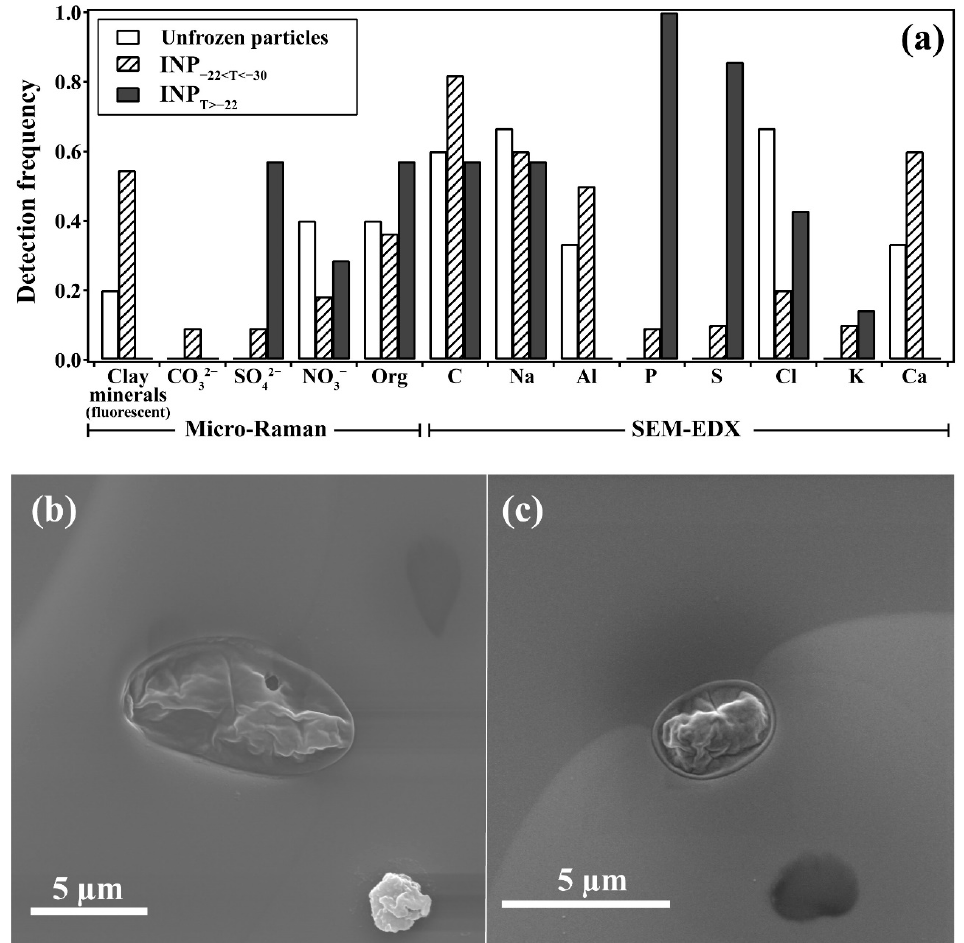
Figure 2. Summary of chemical and morphological characterization by micro-Raman analysis and scanning electron microscopy–energy-dispersive X-ray spectroscopy (SEM-EDX). The shading indicates INPs that formed ice crystals in individual particle chemical analysis: ( a ) above − 22 °C (striped bar) and above − 30 °C (solid gray bar); unfrozen particles are denoted by the white bars. Detection frequencies ( a ) were accounted for if the particle contained atomic ratios of elements (excluding C and P) exceeding 15% in semi-quantitative EDX analyses. Significantly higher peak intensities were found for carbon and phosphorus relative to the background substrate (Table S2). ( b , c ) Electron microscopic images showing the morphology of an efficient INP collected during a rainfall event. These INPs formed ice crystals at ( b ) − 20.5 °C and ( c ) − 20.3 °C using the IDFM. The second group of seven INP T > − 22 was tested for their heat sensitivity by comparing the freezing temperatures before and after heat treatment. Additionally, the relatively inefficient 32 INP − 22 < T < − 30 at temperatures above − 22 °C were also tested for their heat sensitivity for comparison (Figure 3). As shown in Figure 3a, the INP − 22 < T < − 30 showed the least change in their IN activity following heat treatment, and the temperature difference was less than 12 °C (Figure 3a). Recall that the chemical analyses by micro-Raman and EDX showed that even the INP − 22 < T < 30 contained OM